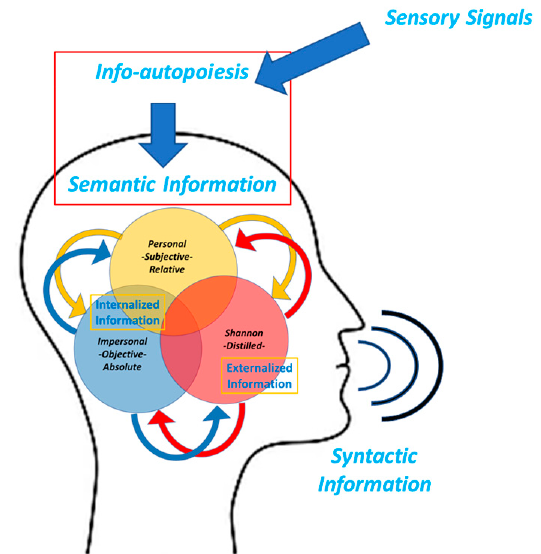
Figure 3. Info-autopoiesis of sensory signals into semantic and syntactic information.